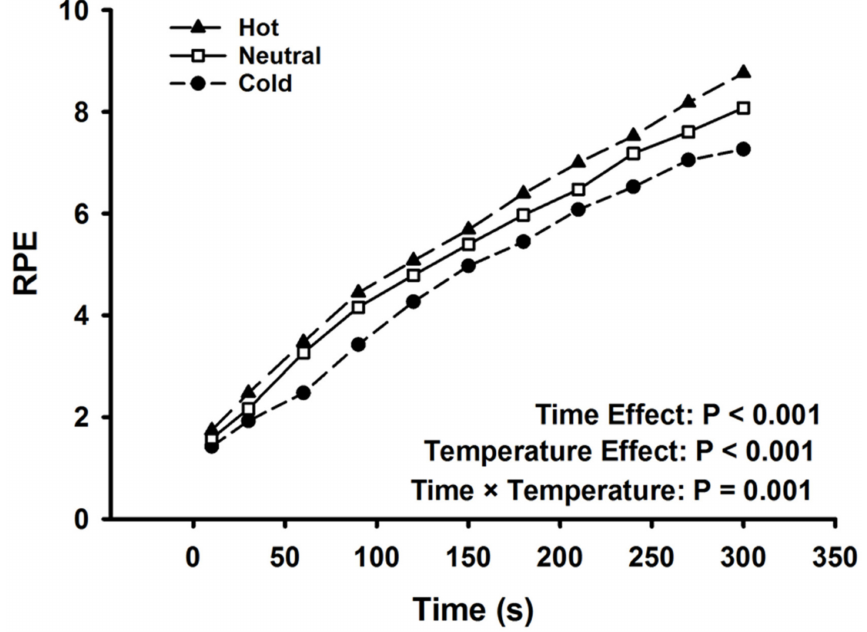
Figure 4. Ratings of perceived exertion throughout the fatiguing task. There was a main e ff ect of time and temperature condition as well as an interaction ( p < 0.001). Data are displayed as mean values. Standard deviation bars were removed for